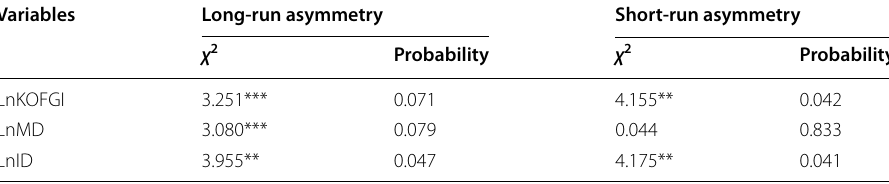
Source: authors’ estimation from UNDP, WDI, and ETH Zurich KOF data ** and *** imply significant at 5% and 10% level,